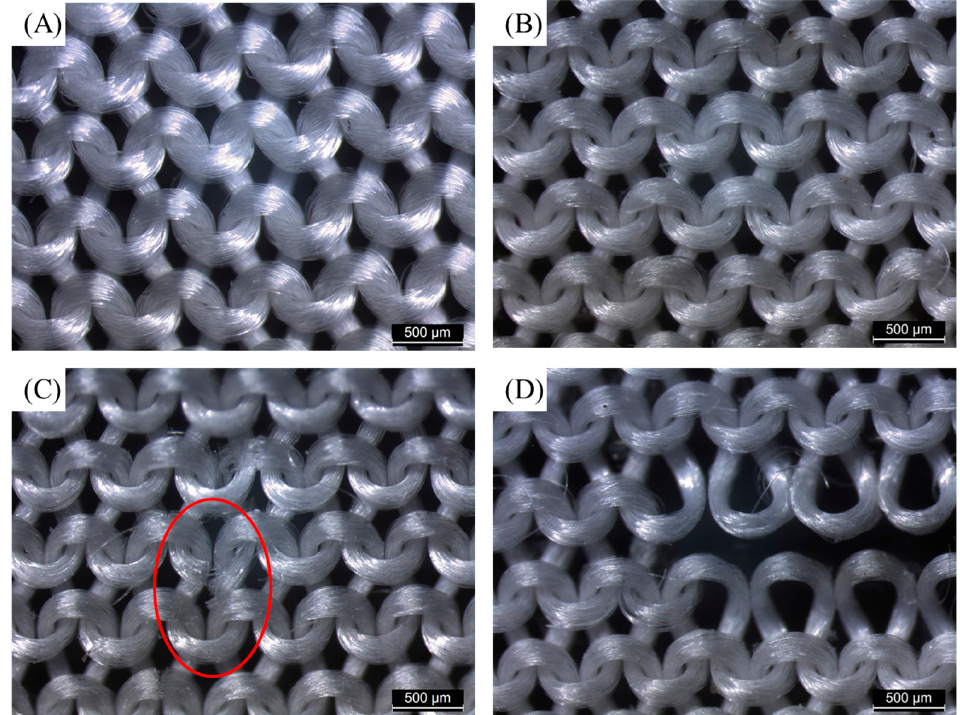
Figure 7. Digital microscopic images of ( A ) the initial PLA/PHB knitted fabrics and the PLA/PHB knitted fabrics after ( B ) two weeks, ( C ) four weeks, and ( D ) eight weeks exposed under both UV light and aerated seawater. Note: the red circle indicated the broken part in the yarns of the fab- rics.